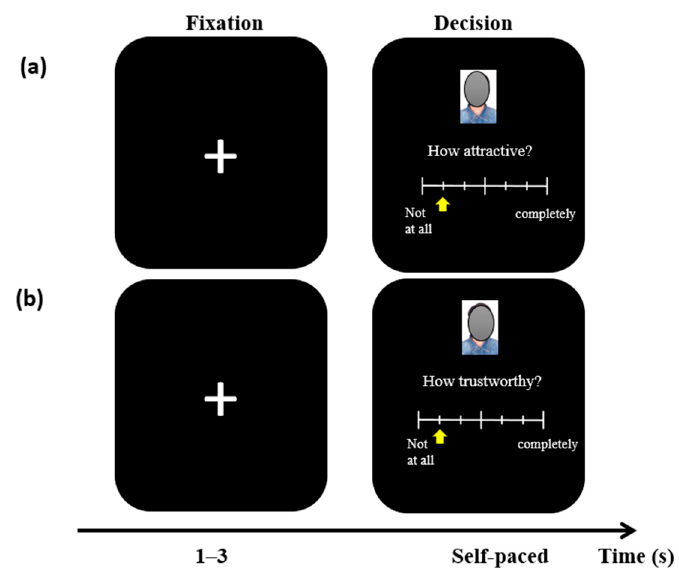
Figure 6. The rating of attractiveness ( a ) and trustworthiness ( b ) of each partner. After a Fixation was shown (1–3 s), the Decision screen showed the face of the partner and the rating scale. Participants made their ratings by moving the arrow with the left or right arrow key. They locked their choices by pressing the enter key. Participants made their ratings at their own pace. Note. The texts in the original picture are in Chinese. They are translated into English for communication